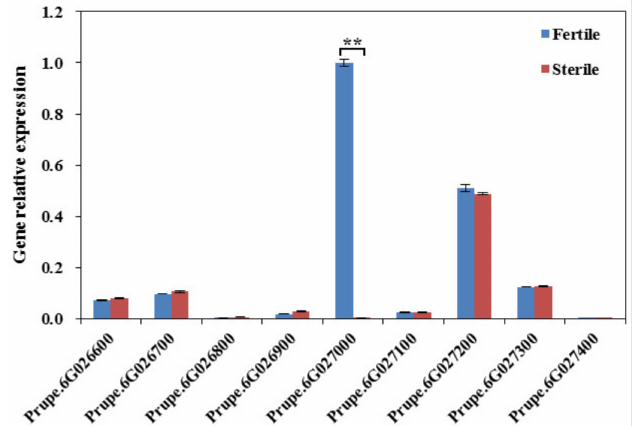
Figure 4. Expression patterns of the nine candidate genes related to peach pollen fertility. The blue bars and red bars indicate the relative expression in the anther samples of the fertile cultivar ‘Da Hong Pao’ and sterile cultivar ‘Annong Shui Mi’, respectively. ** p < 0.01.